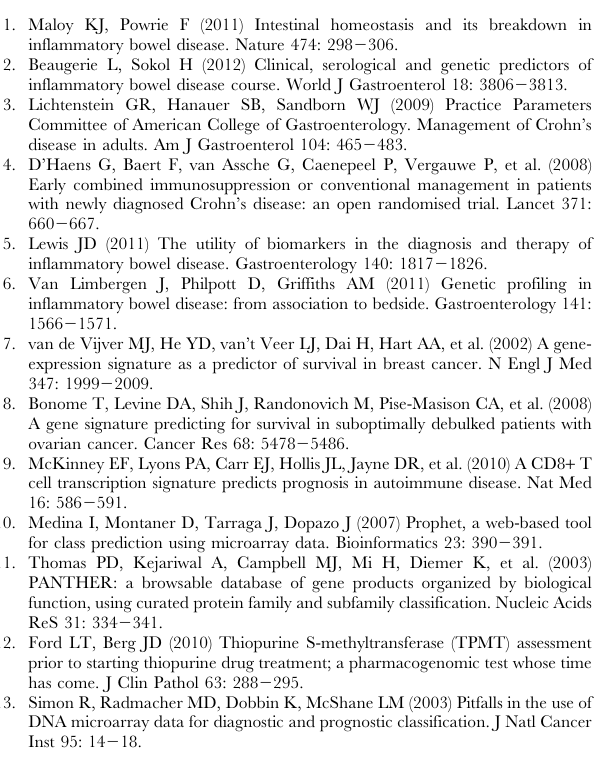
Table S3 Genes validated by real time-PCR and primers used. (DOC) Table S4 Gene expression changes identified in GEO Profiles